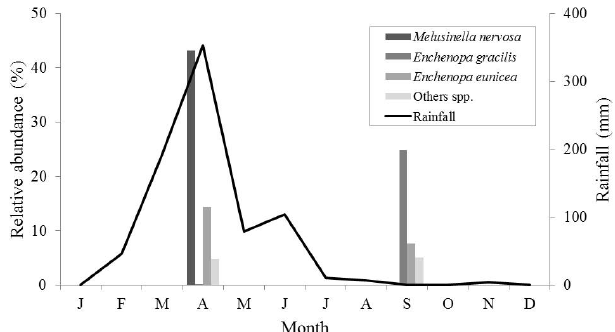
Fig 1. Monthly rainfall variation (mm) and relative membracid abundance (%) collected in São José dos Cordeiros, Paraíba in 2006 (Source: